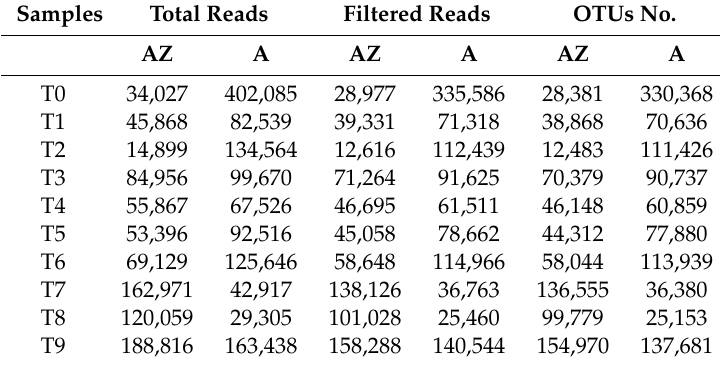
Table 2. Number of raw 16S rDNA gene amplicon reads and bacterial phylotypes defined to 90% identity of Amarillo Zamorano (AZ) and A (A) silages. Samples Total Reads Filtered Reads OTUs No. AZ A AZ A AZ A